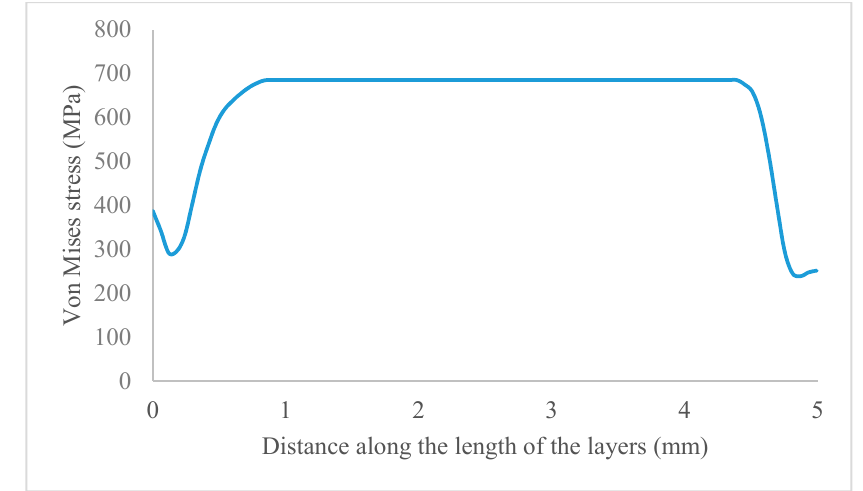
Figure 17. Von Mises stress after final cooling along the length of the deposited layers.